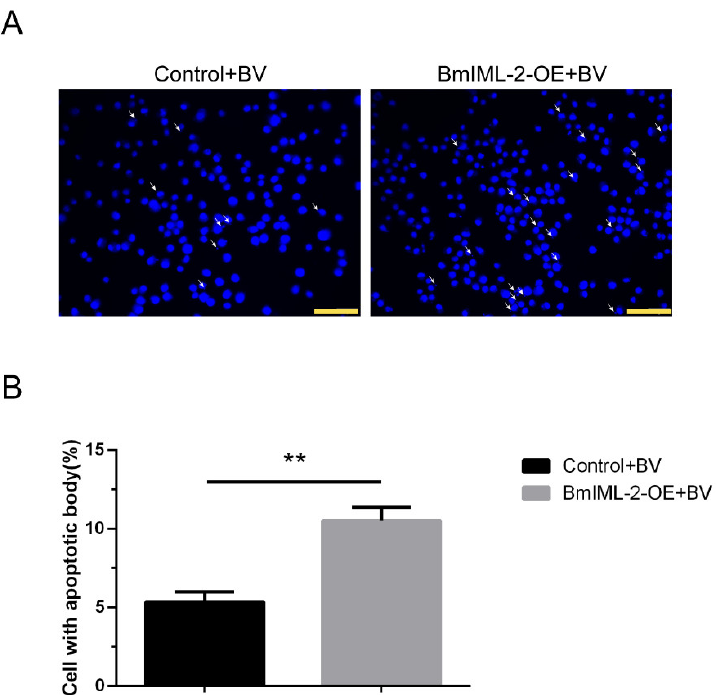
Figure 7. Observation of apoptotic bodies induced by BmNPV after the overexpression of BmIML-2 in BmN cells. ( A ) The BmN cells overexpressing BmIML-2 were infected with BmNPV. After 48 h viral infection, cells were visualized under a fluorescence microscope. Nuclei stained with 4,6-diamidino-2-phenylindole (DAPI), blue , scale bar = 100 µm. Apoptotic bodies are marked with white arrows. ( B ) The percentage of cells in apoptotic morphology. Statistical analysis was carried out by using GraphPad Prism 6.0 software. Error bars represent means ± S.D. of three separate experiments. Asterisks indicate significant differences compared with the control (unpaired t -test; **, p < 0.01).